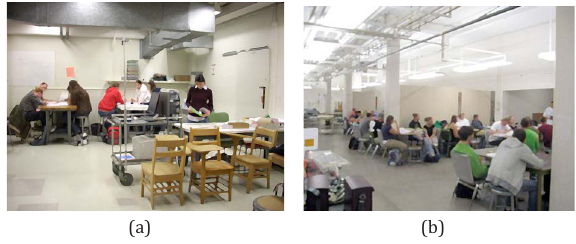
FIG. 2. (cid:1) Color (cid:2) The photo on the left shows the UM tutorial room, which is located off a little-used hallway. The photo on the right shows the CU tutorials, which are conducted in three adjacent bays located in a cavernous room in which many other classes